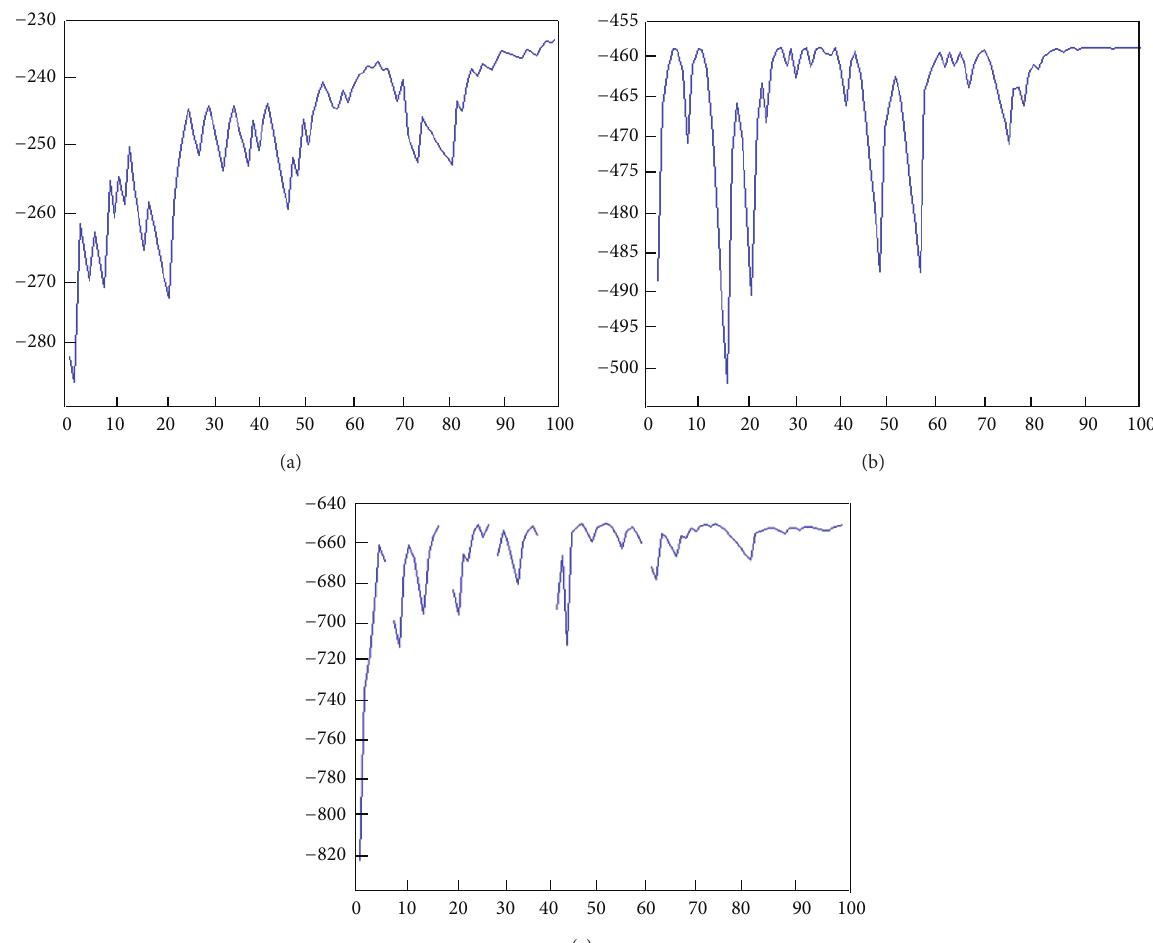
Figure 3: Ln 𝐿(𝑏,𝛽,𝑠) versus iteration counter for Example 2: (a) 𝑛 = 100 , (b) 𝑛 = 200 , and (c) 𝑛 = 300